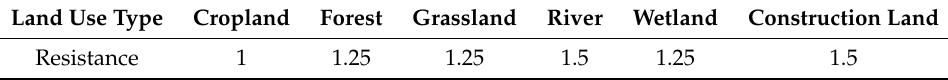
Table 1. Resistance of each land use